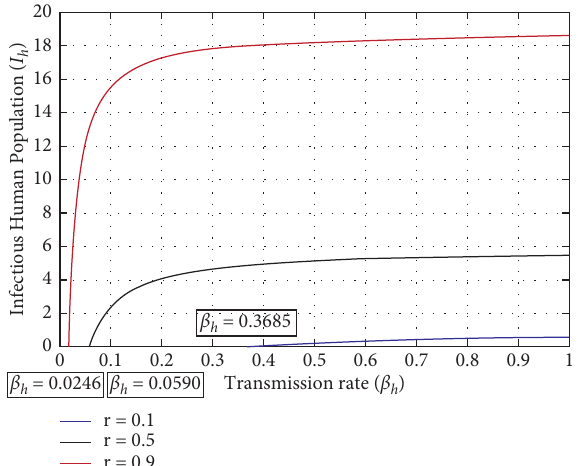
Figure 13: Bifurcation diagram with different values of r when k �